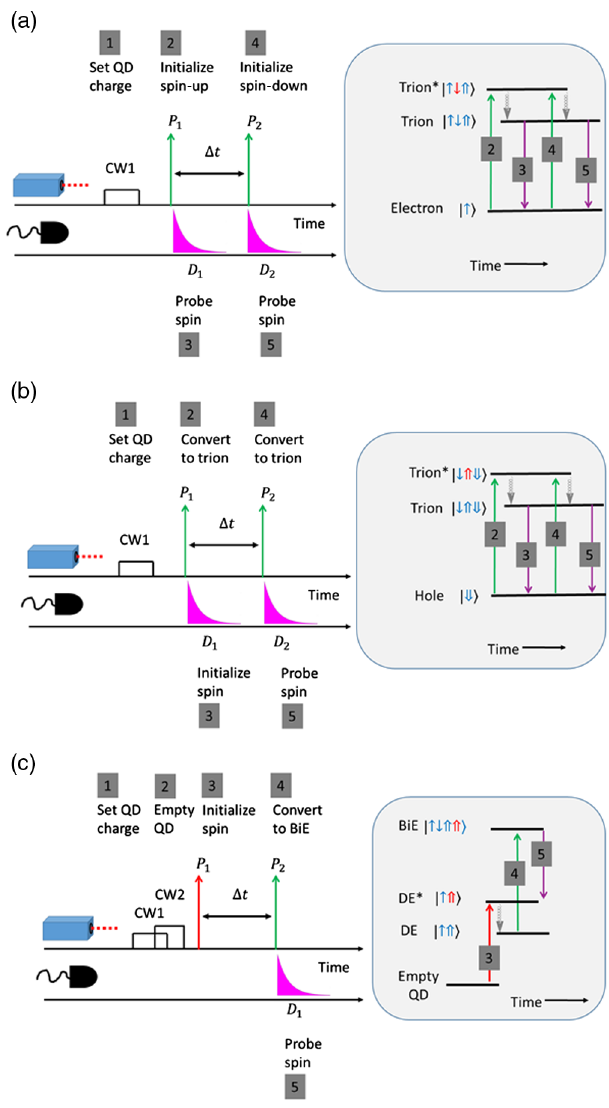
FIG. 3. Schematic description of the experiments for measuring the spin dynamics of (a) positive and negative trions, (b) single electron and single heavy hole. (c) Dark exciton. The optical transitions in each experiment are described by the energy-level diagram to the right. The carrier ’ s spins are marked in the figure using the notations of Fig. 1, where blue (red) color represents ground (excited) single carrier states. CW1 and CW2 represent the 20-ns gated CW laser pulses where P 1 and P 2 represent the 12-ps pulses produced by the synchronously pumped and cavity- dumped dye lasers. Δ t is the time delay between the two pulses in each repetition period, controlled by two cavity dumpers and a delay line. D 1 and D 2 represent the emission and time-resolved detection of the two single photons emitted as a result of the P 1 and P 2